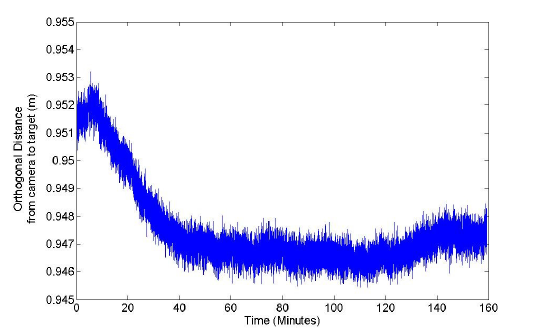
Figure 2: Determination of camera warm-up time